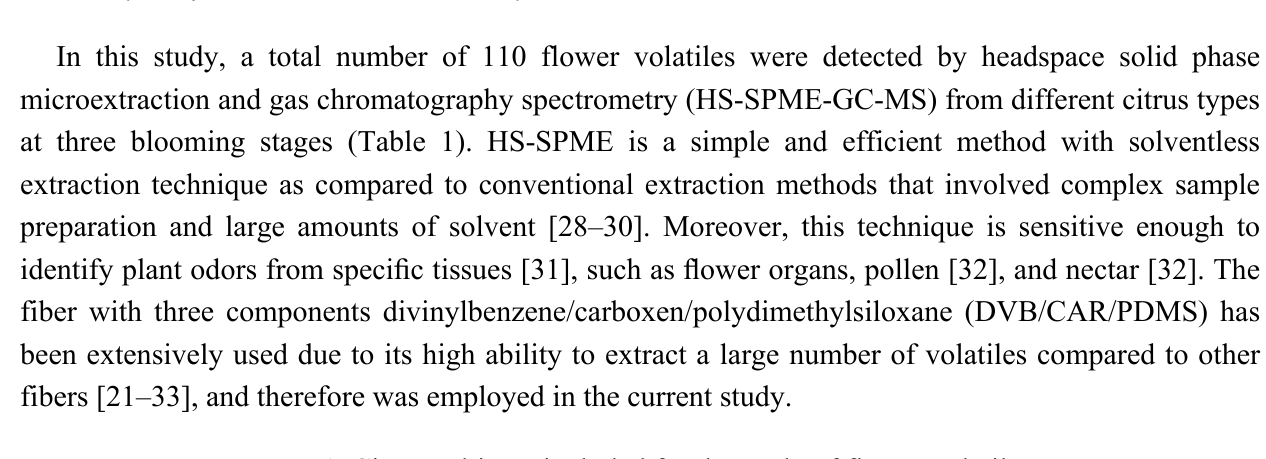
Table 1. Citrus cultivars included for the study of flower